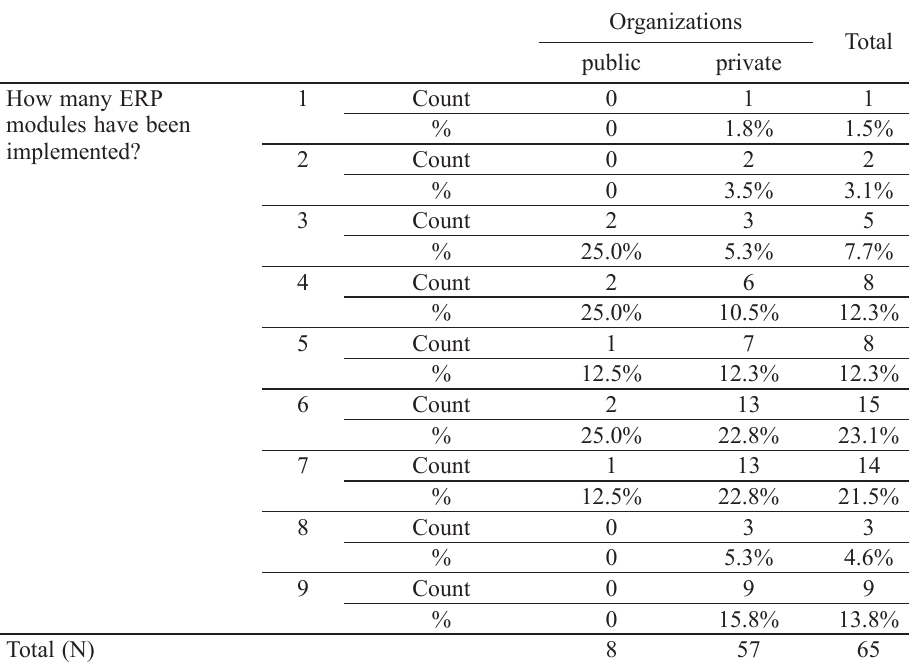
Table 5. Implementation of modules in public and private organizations Modules implementation in Public/private organizations